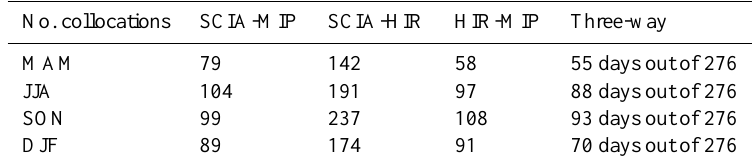
Table 1. Number of daily zonal mean SCIAMACHY–MIPAS–HIRDLS collocations in the 2005–2007